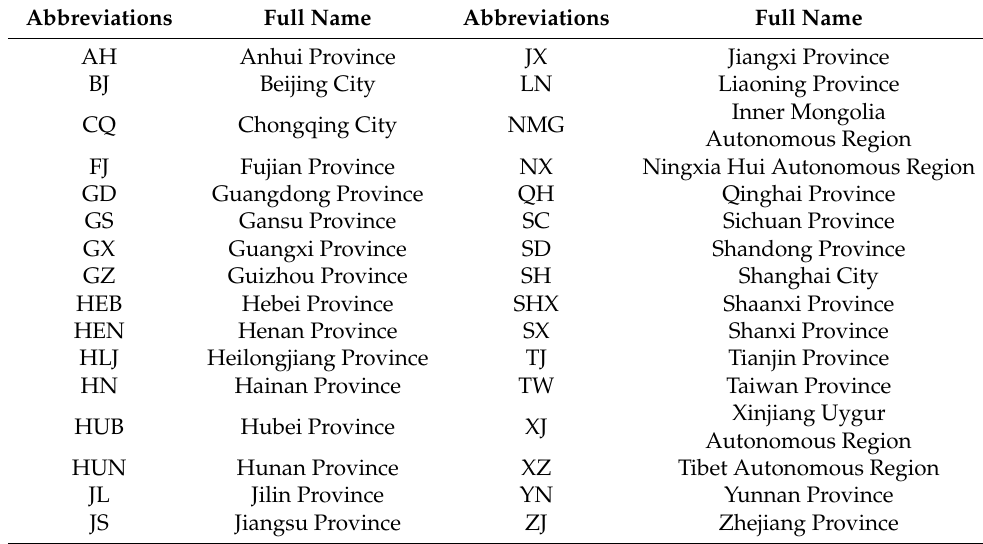
Table A1. Abbreviations of Chinese provincial regions and their corresponding full